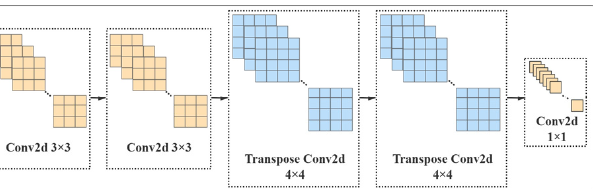
Figure 3. Structure diagram of the transposed convolutional network: yellow is convolution, blue is transpose convolution.